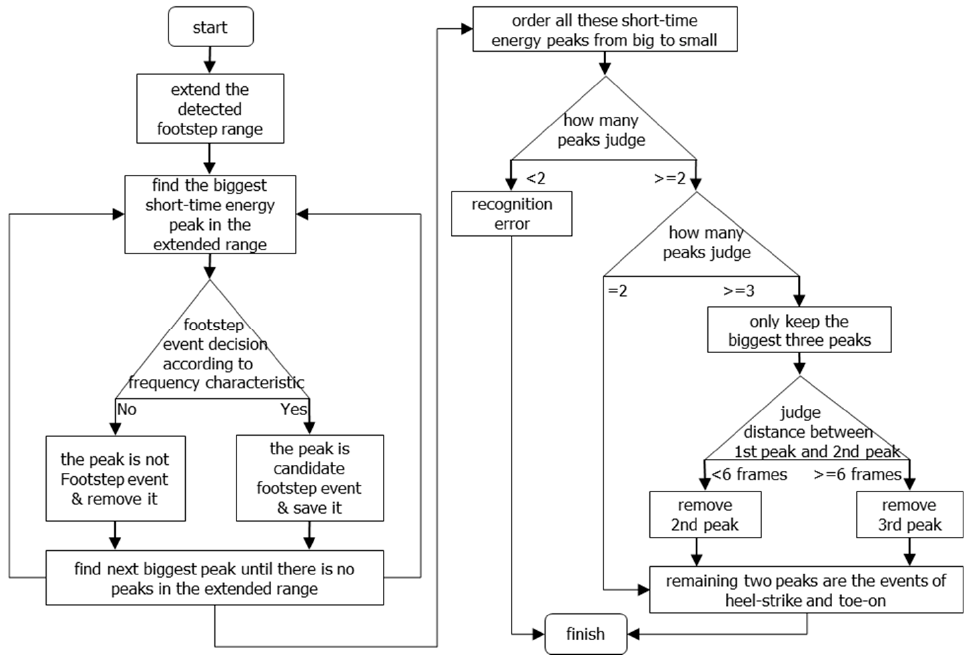
Figure 7. Diagram of biggest-energy-based method for detection of heel-strikes and toe-ons.